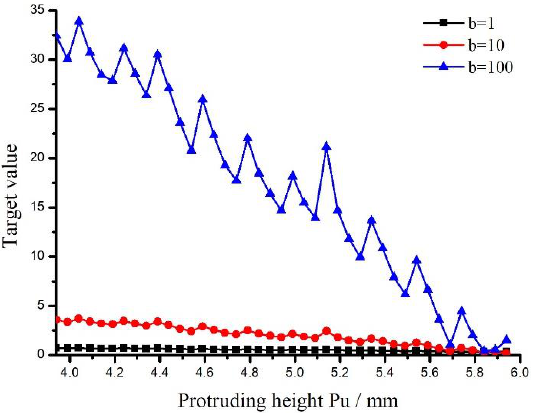
Figure 13. The target value when the weight coefficient b is from 1 to 100. Table 4. The optimum value when the weight coefficient b is from 0.0001 to 10,000. Weight Coefficient 0.0001 0.001